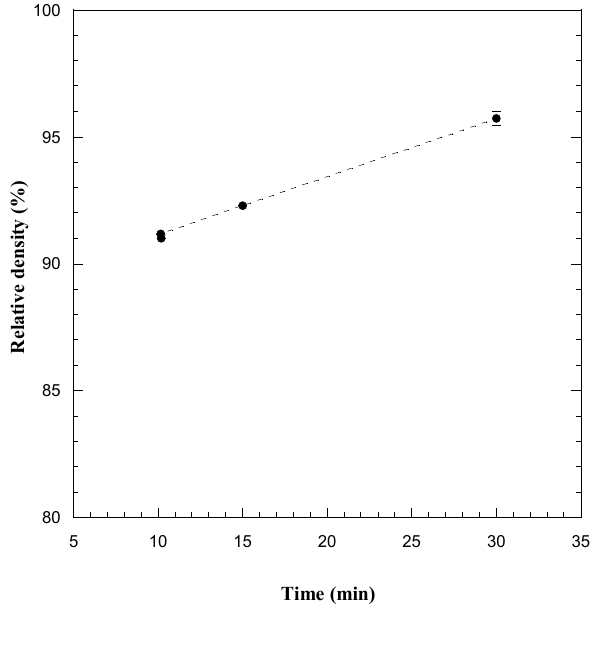
Figure 10. Influence of the sintering time on sample density during consolidation by SPS ( T = 1800 °C, P = 20 MPa) of TaB D SHS. Adapted from